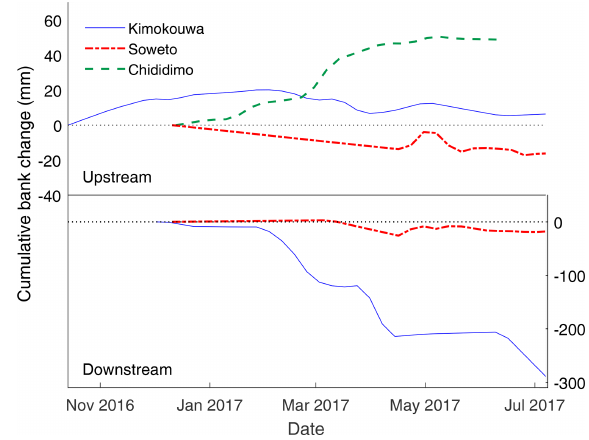
Figure 8. Average weekly change in the bank soil at 1 / 4, 1 / 2, and 3 / 4 bank height. Positive values represent deposition; negative val- ues represent erosion. Standard error bars are